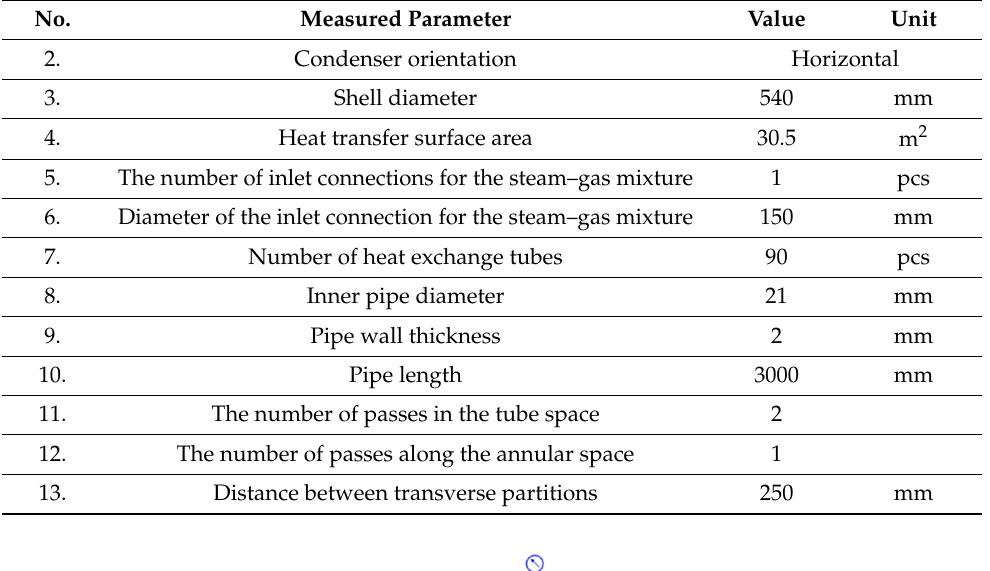
Table 4. Condenser parameters.